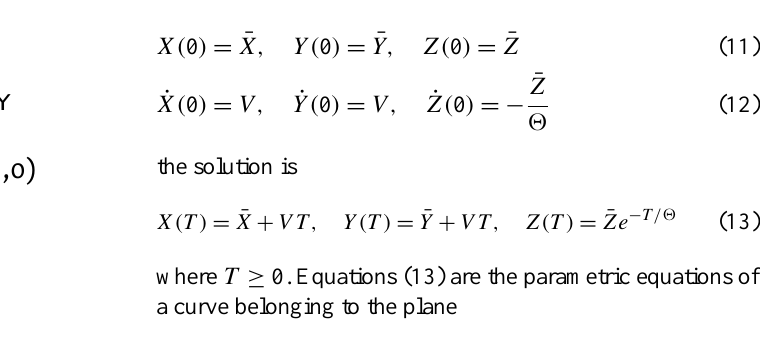
Fig. 2. The sticking region H